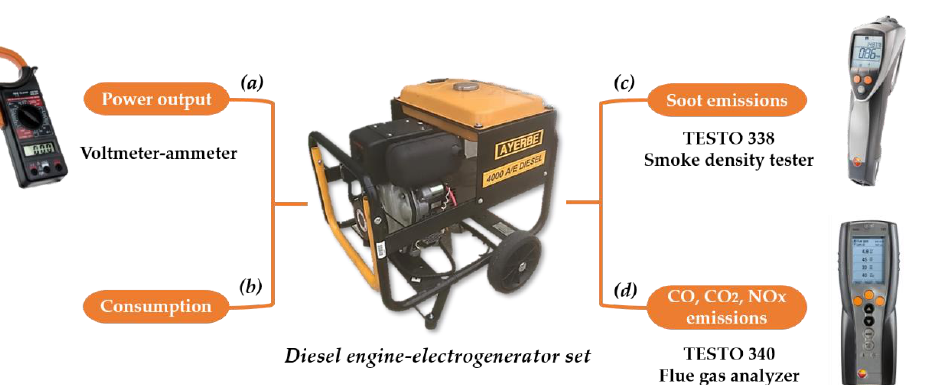
Figure 2. Experimental methodology employed for the evaluation of the biofuels using a Diesel Engine-Electrogenerator Set based on ( a ) power output from a voltmeter–ammeter devise, ( b ) fuel consumption, ( c ) soot emissions using a smoke density tester, and ( d ) CO, CO 2 , and NO x emissions, using a flue gas